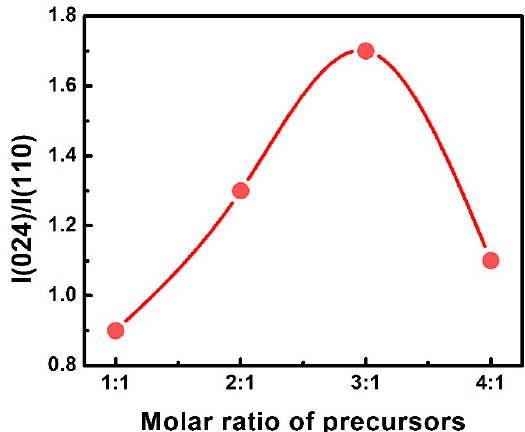
Figure 5. Intensity ratio of the (024) reflection vs. the (110) reflection as a function of different film